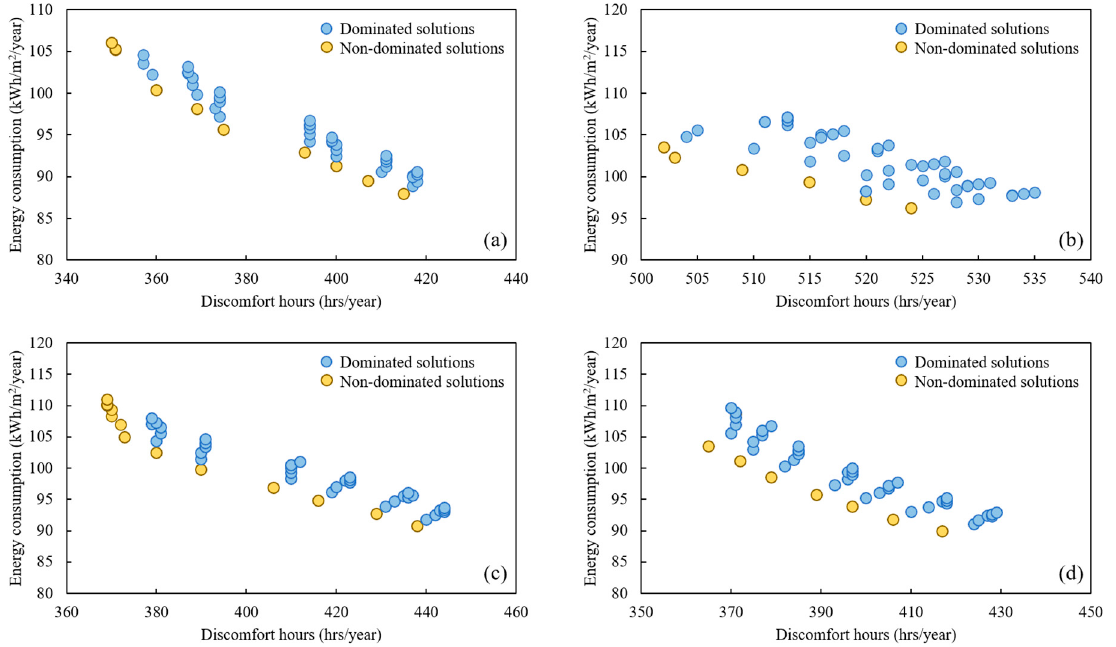
Figure 4. Trade-off between annual discomfort hours and net thermal energy consumption with the variations of U in and SHGC out for NatVent-DSF (all year round, Darwin) for different orientations: ( a ) North, ( b ) South, ( c ) East, and ( d ) West.